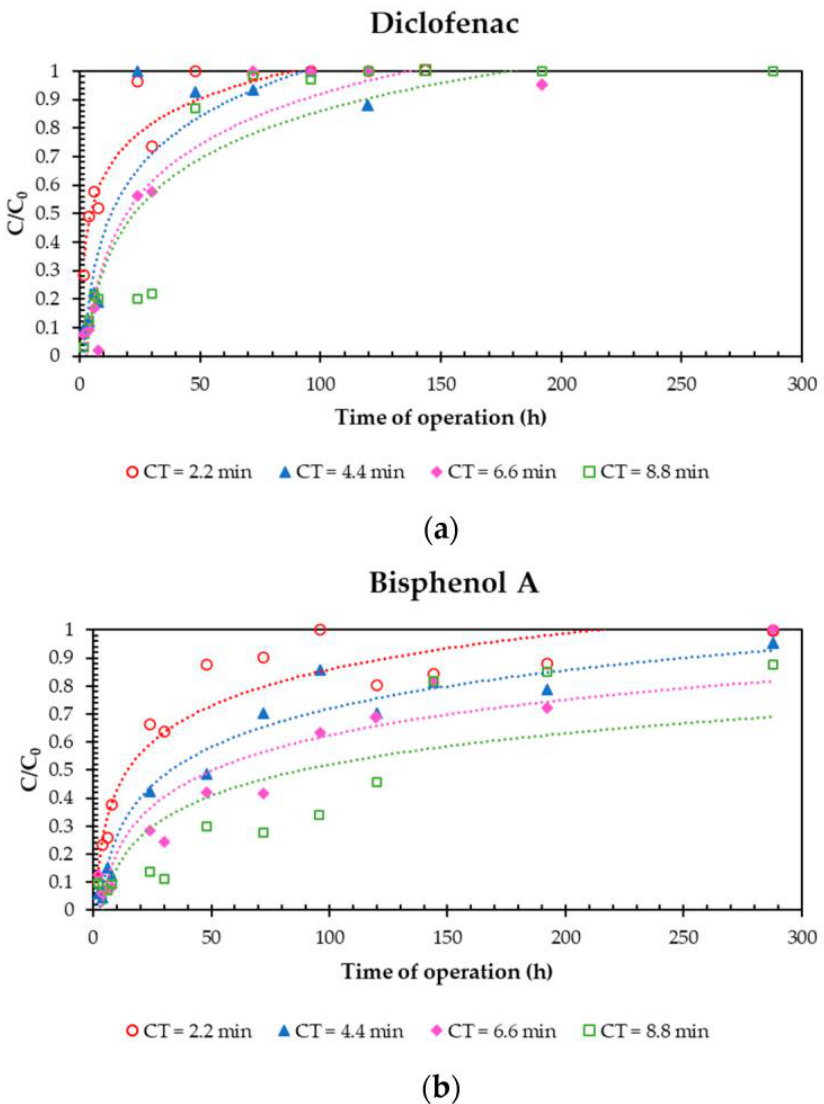
Figure 3. Effect of contact time on the removal efficiency of diclofenac ( a ) and bisphenol A ( b ) (Q = 26 L/d, C 0 = 5 µ g/L, no pH